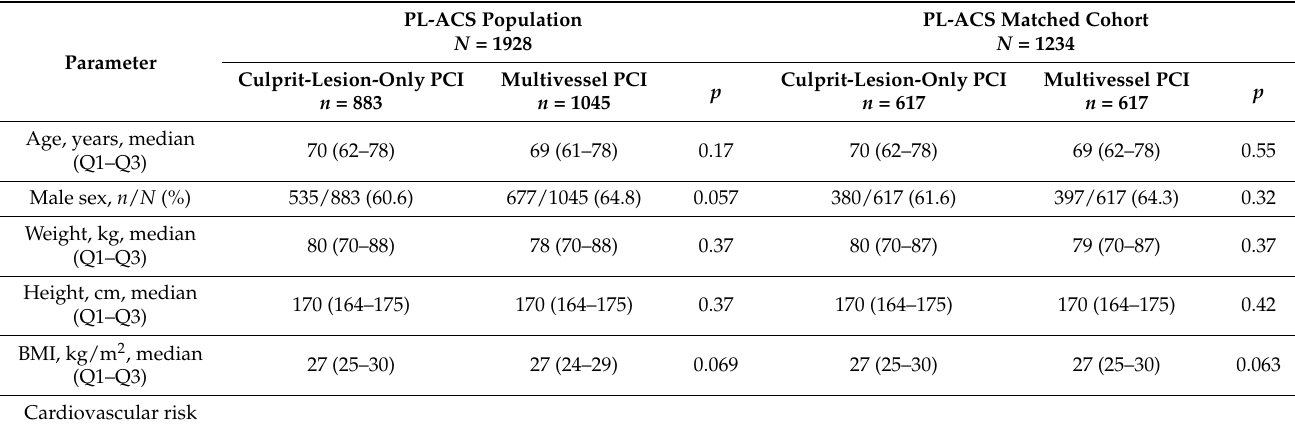
Figure 1. Flow chart for identification of the CULPRIT-SHOCK-like group in the PL-ACS registry population based on the CULPRIT-SHOCK trial inclusion and exclusion criteria. Table 1. Baseline characteristics of study groups of the PL-ACS registry and the CULPRIT-SHOCK